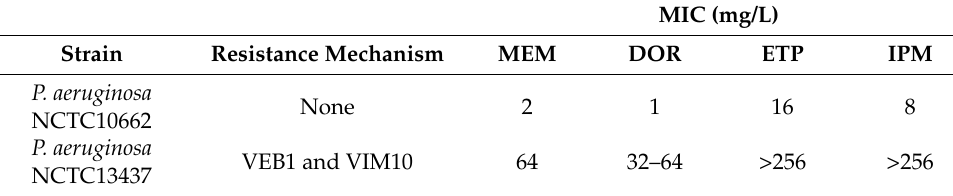
Table 1. Minimum inhibitory concentration (MIC) of P. aeruginosa strains NCTC10662, an antibiotic susceptible control strain, and NCTC13437, an antibiotic-resistant strain carrying the extended- spectrum β -lactamase (ESBL) VEB1, and the carbapenemase VIM10. The experiment was performed in triplicate. MEM—meropenem, IPM—imipenem, DOR—doripenem, ETP—ertapenem. MIC (mg/L) Strain Resistance